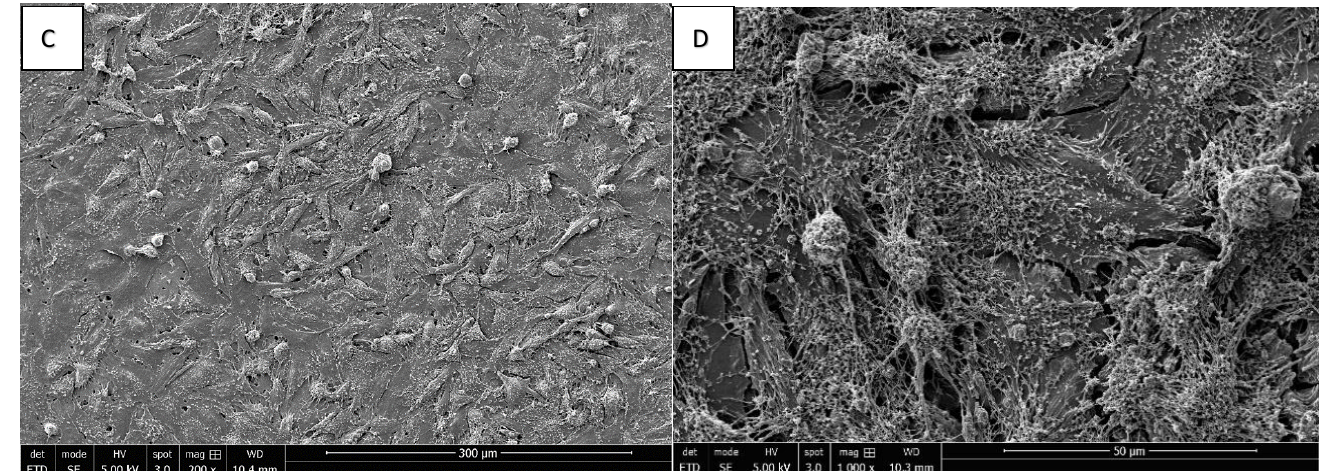
Figure 6. SEM image of Saos-2 cells on rough (( A ) magnification 200×; ( B ) magnification 1000×) and mirror-polished (( C ) magnification 200×; ( D ) magnification 1000×) surfaces of ZrO2 discs at 96 h of incubation.